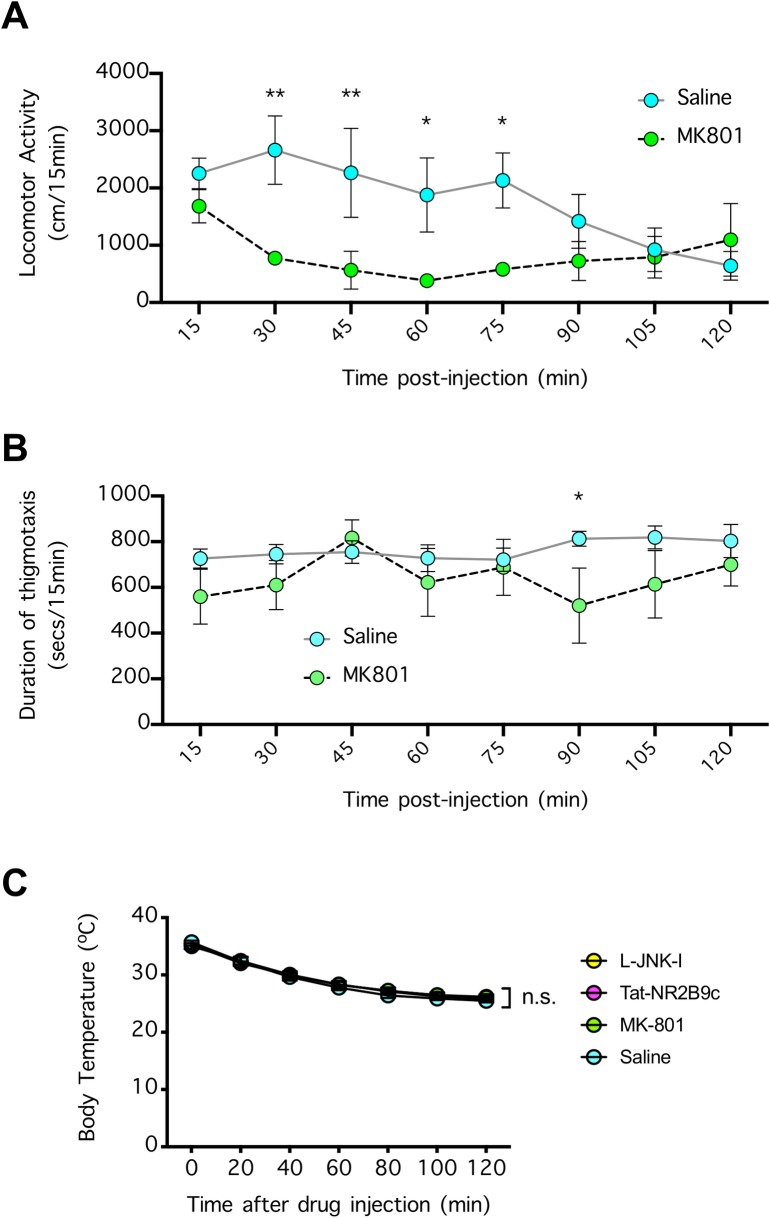
Effect of NMDAR antagonist on the open field behavior and body temperature of the mice.(A) Mice were injected (i.p.) with saline (4 ml/kg) or MK801 (4 mg/kg), and the locomotor activity was investigated in an open field test chamber. n = 4 per group. Data were compared by 2-way repeated measures ANOVA (matching locomotion over time from the same animal) followed by Fisher’s LSD test. *P<0.05 and **P<0.01 indicate significant differences compared to the saline-treated mice. (B) Thigmotaxis of mice in A was determined by measuring the time they spent near the chamber wall. n = 4 per group. Data were compared by 2-way repeated measures ANOVA (matching thigmotaxis measured from the same animal) followed by Fisher’s LSD test. *P<0.05 indicates a significant difference compared to the saline-treated mice. (C) Mice were injected (i.p.) with MK801 (4 mg/kg), Tat-NR2B9c (8 mg/kg), L-JNKI-1 (8 mg/kg), or vehicle (saline at 4 ml/kg), and after light sedation by 1% isoflurane, the body temperature was measured by a rectal probe. n = 5 per group. Data were compared by 2-way repeated measures ANOVA (matching body temperature from the same animal); n.s. indicates no significant difference. In A-C, error bars indicate the mean ± SEM.